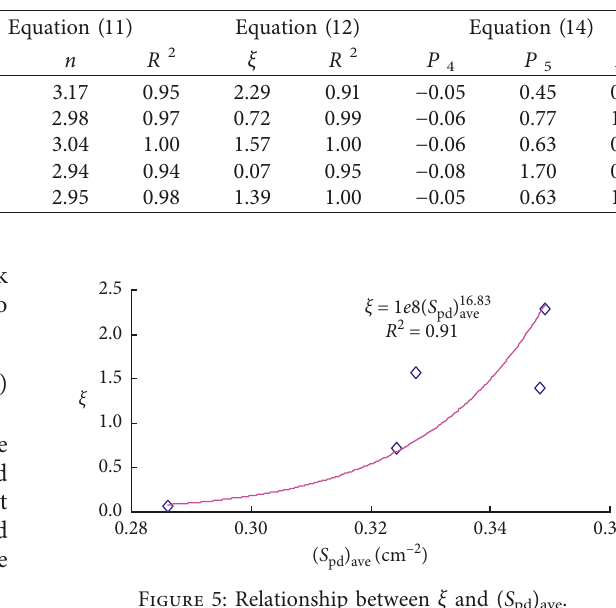
Table 3: Fitting parameters and correlation coefficients R 2 .